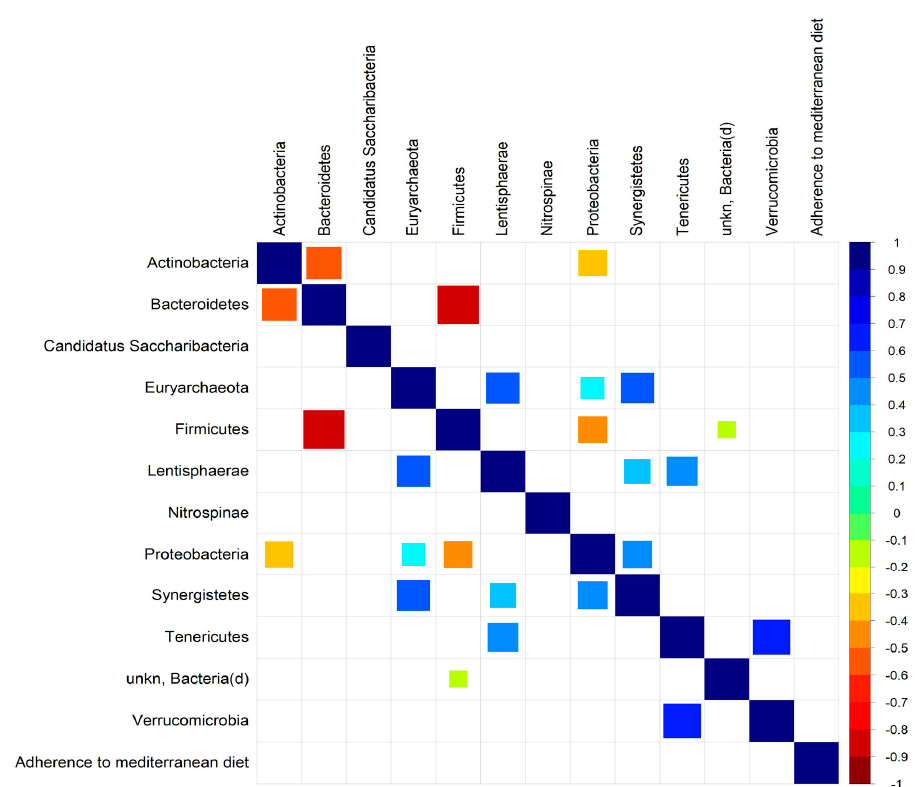
Figure 4. Association of gut microbiota profile with clinical pathological features in RA patients at the family ( A ), genus ( B ), and phylum ( C ) levels.